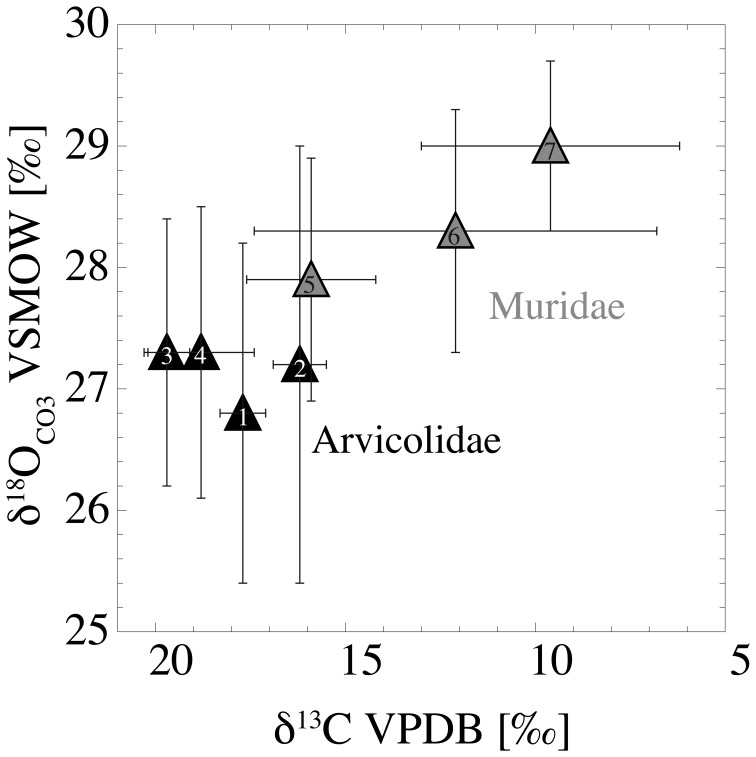
Mean δ18OCO3 and δ13C values of bulk incisors of the seven analysed rodent species (n = 10 in each species) with 1σ error bars.1: A. terrestris, 2: M. glareolus, 3: M. agrestis, 4: M. arvalis, 5: A. sylvaticus, 6: M. musculus, 7: R. norvegicus.